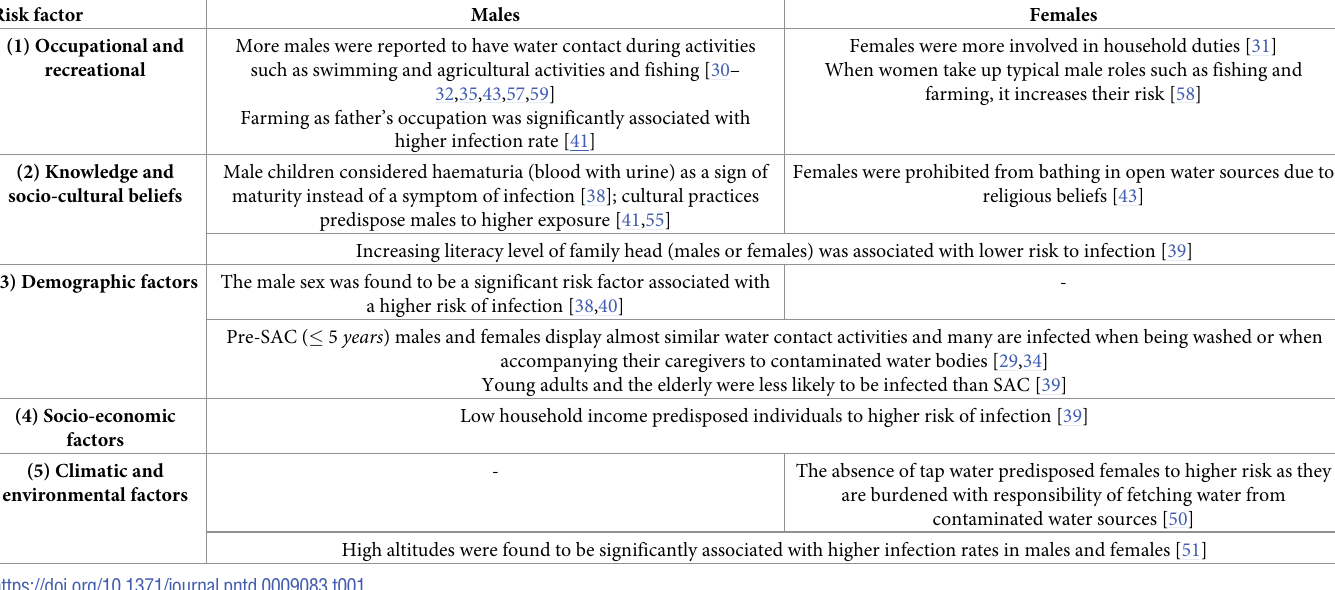
Table 1. Risk factors and how they vary between males and females in included studies for S . haematobium and S . mansoni . Risk factor Males